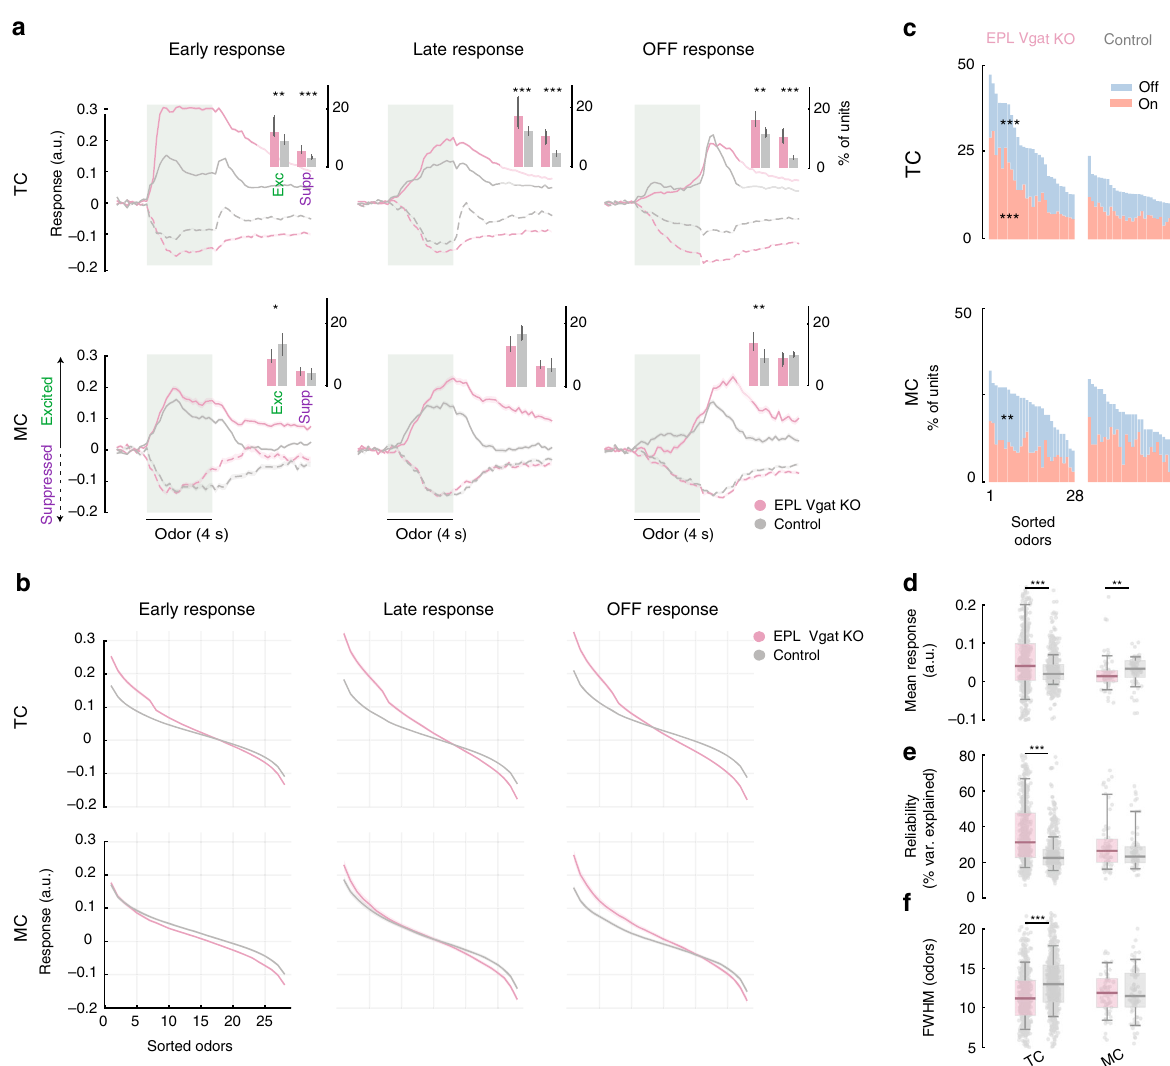
displayed higher responses to the most excitatory odors, and lower responses to the most inhibitory odors (Fig. 6c). Thus, pTCs were functionally impacted by loss of EPL-IN Vgat in a similar manner to TCs lacking the mRuby2 reporter.